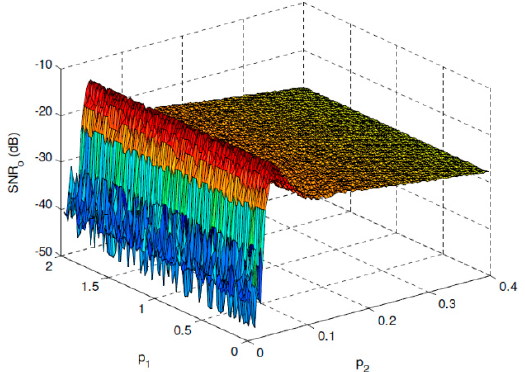
under SNR i = − 30 dB. 2